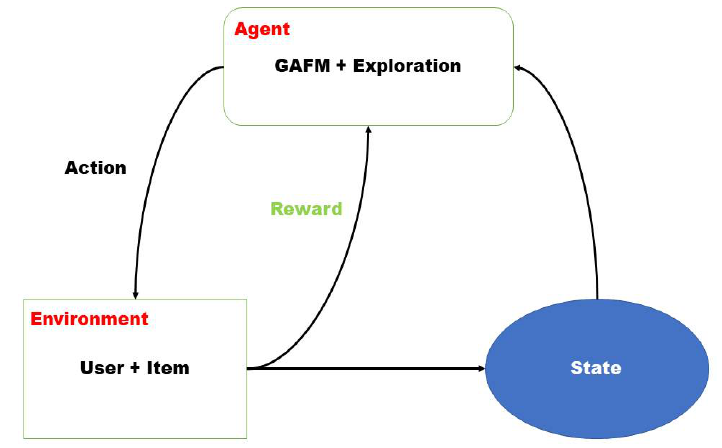
Figure 5. DRFM system